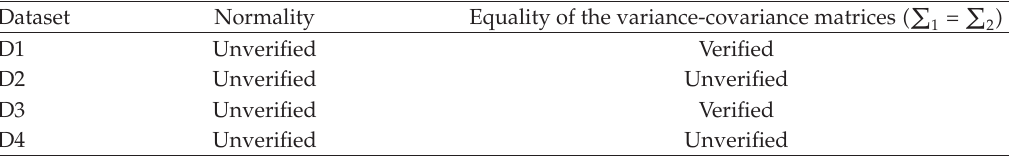
Table 1: Normality test and equality of the variance-covariance